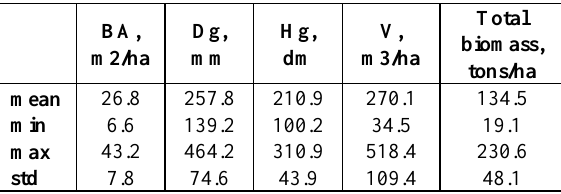
Table 3. List of TSX data. Images D1-D3 are from descending orbit and A1-A3 from ascending